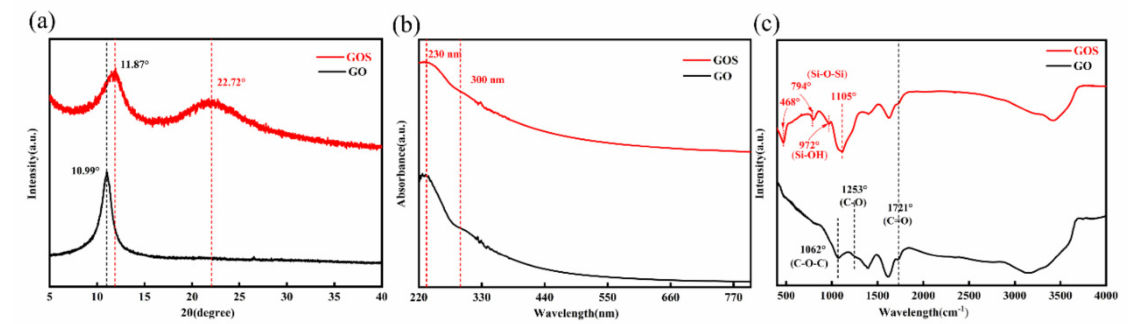
Figure 4. ( a ) The XRD spectra of GO and GOS. ( b ) The UV–vis spectra of GO and GOS in water. ( c ) The FTIR spectra of GO and